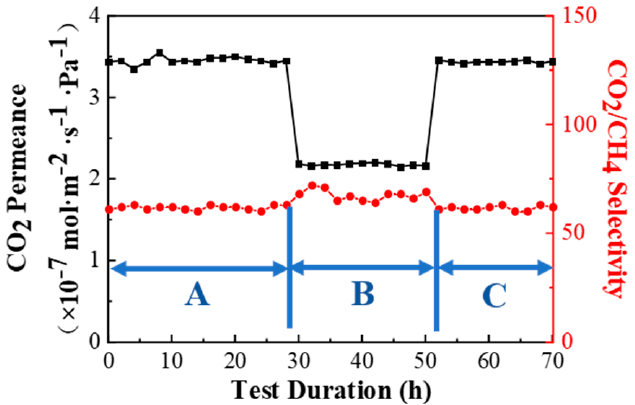
Figure 13. Short-to-mid-term stability of PPPS/PDMS/PSf composite membrane. Test conditions: 298 K, saturated humidity, and 0.15 MPa.